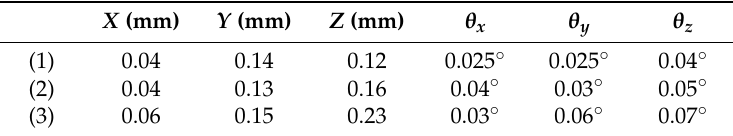
Table 4. Six-DOF measurement peak